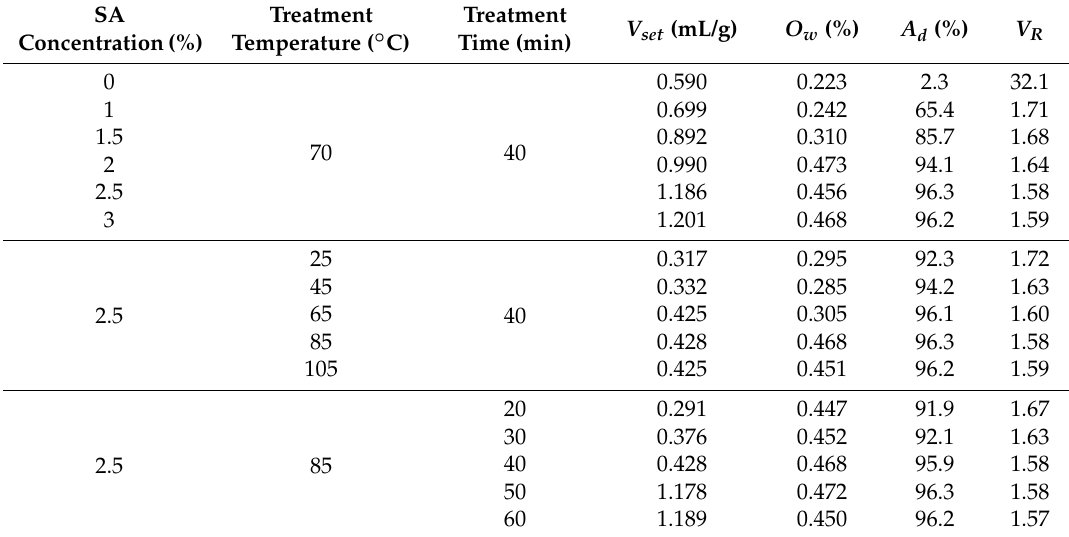
Table 2. Process optimization of SA treatment of ES